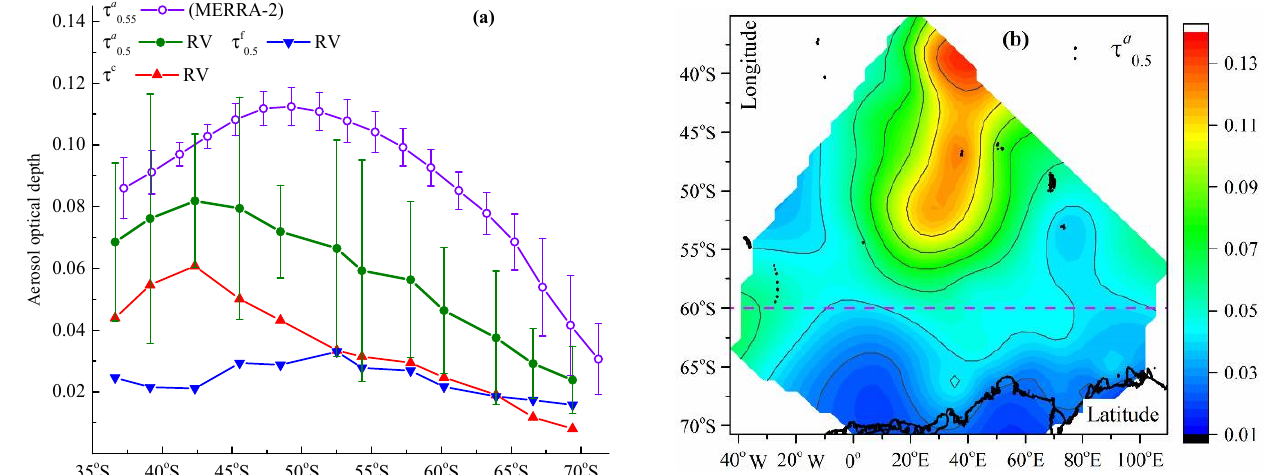
Figure 3. Average spatial distribution of the atmospheric AOD: ( a ) latitude behavior using ship-based (RV) measurements and MERRA-2 reanalysis data, and ( b ) latitude–longitude distribution based on the interpolation of ship-based data (dashed line indicates the Southern Ocean border).